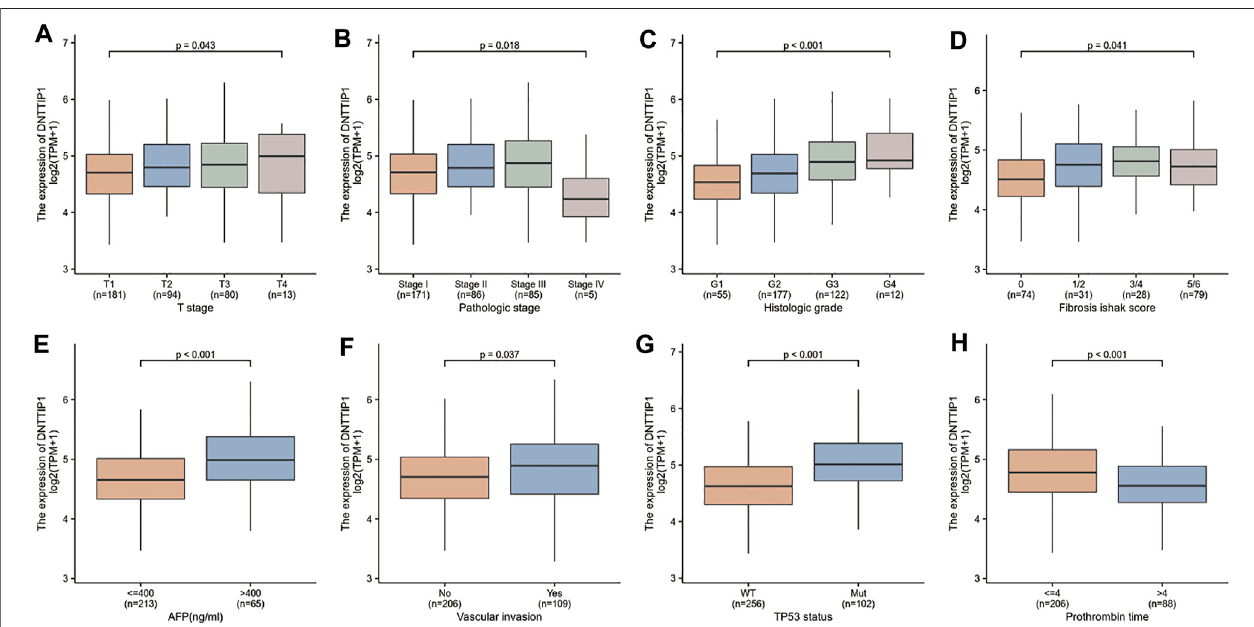
FIGURE4| AssociationbetweentheDNTTIP1expressionanddifferentclinicopathologicalcharacteristics. (A) AssociationbetweentheDNTTIP1expressionandT stage of HCC, (B) pathologic stage, (C) histologic grade, (D) fi brosis Ishak score, (E) AFP, (F) vascular invasion, (G) TP53 status, and (H) prothrombin time.